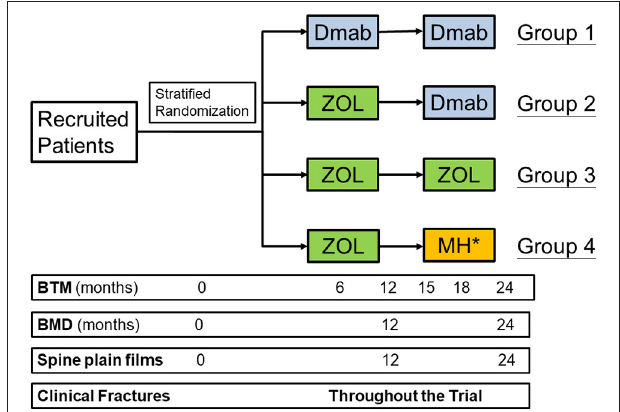
FIGURE 1 | The flowchart of the study. Dmab, denosumab; ZOL, zoledronate; MH, monitored drug holiday; BTM, bone turnover markers; BMD, bone mineral density. *An extra ZOL injection will be given once the C-terminal telopeptide levels raise above the pre-specified threshold, 0.573ng/mL in post-menopausal women and 0.584ng/mL in men,